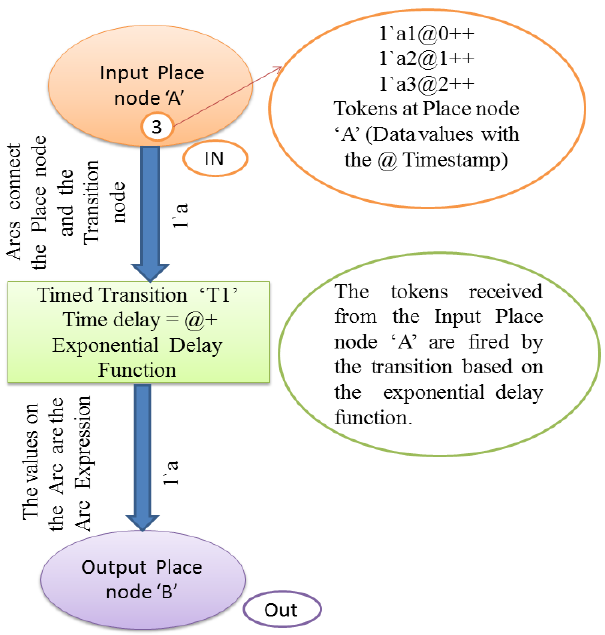
Figure 2 . Example of a Stochastic Coloured Petri